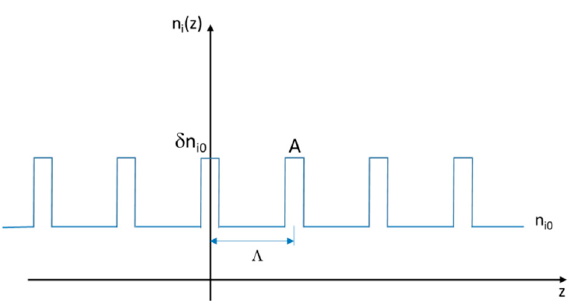
Figure 3. Longitudinal refractive index modulation for the i (x,y) axis.